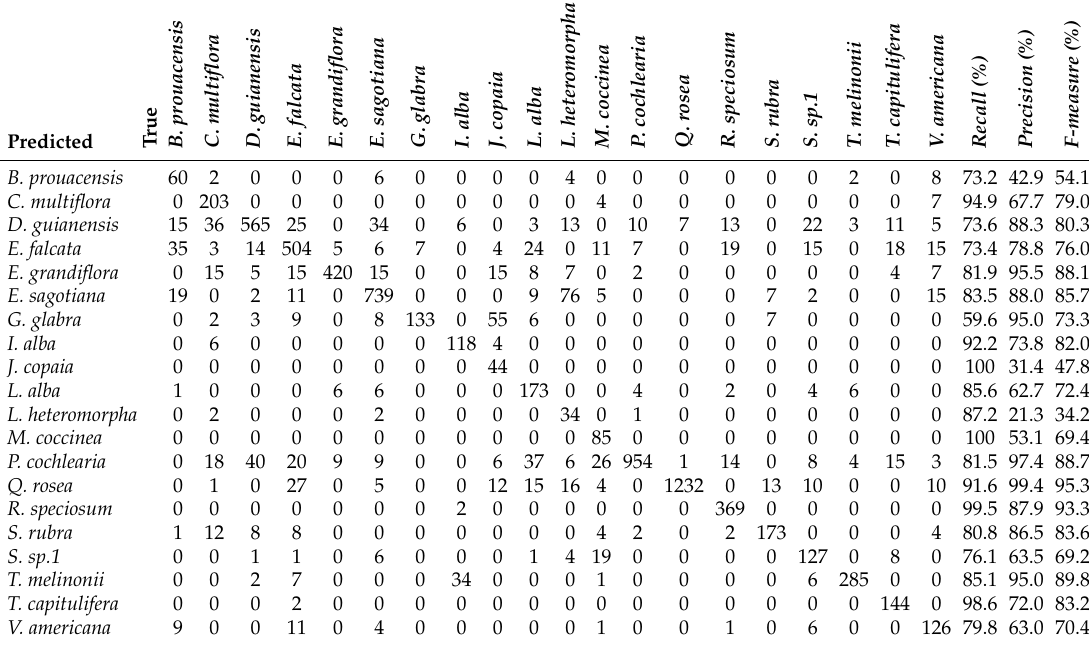
Table 5. Confusion matrix from L1b Spa.F, norm. at the crowns scale for the twenty most abundant species.